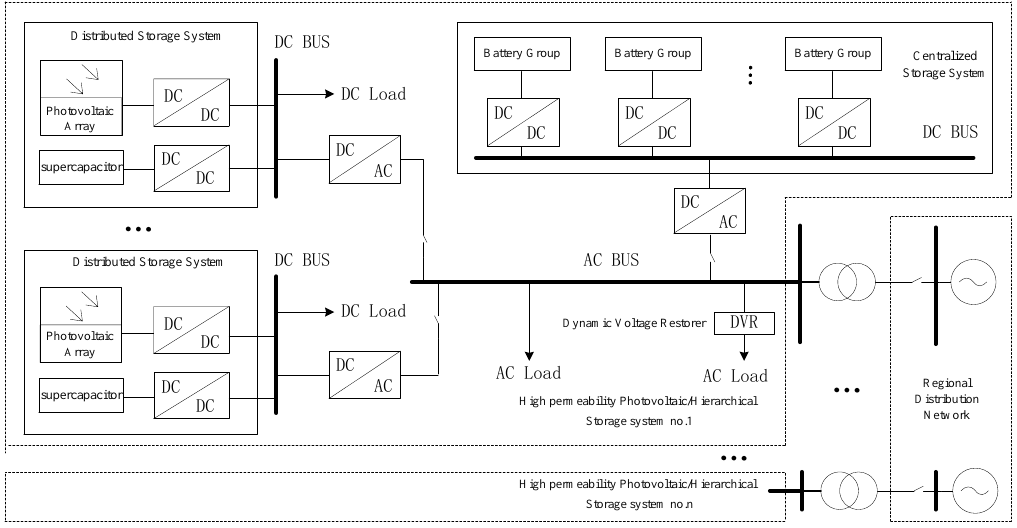
Figure 4. Construction of a distribution network with high permeability photovoltaic/hierarchical storage.